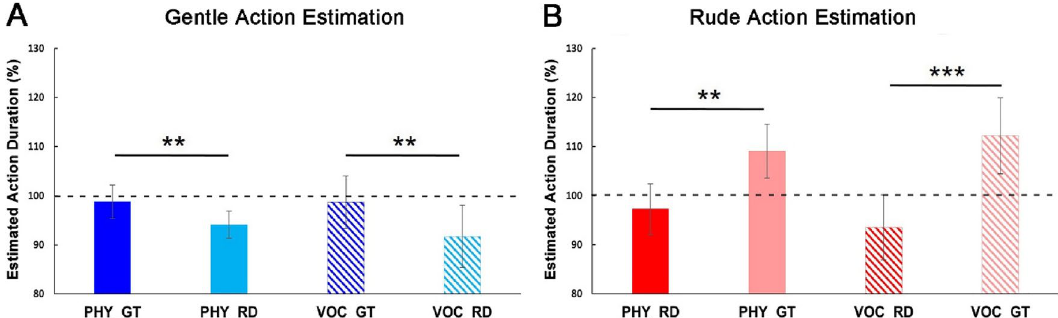
Figure 4. Results of gentle ( A ) and rude ( B ) action estimation. Estimated action durations normalized to the baseline condition are reported on the y-coordinate. The dotted line in correspondence of 100% refers to the baseline. PHY physical request, VOC vocal request, GT gentle vitality form, RD rude vitality form. Vertical bars represent the standard errors (SE). Horizontal bars indicate statistical significance (** p < 0.01, *** p < 0.001). Effect of rude requests on gentle action estimation.